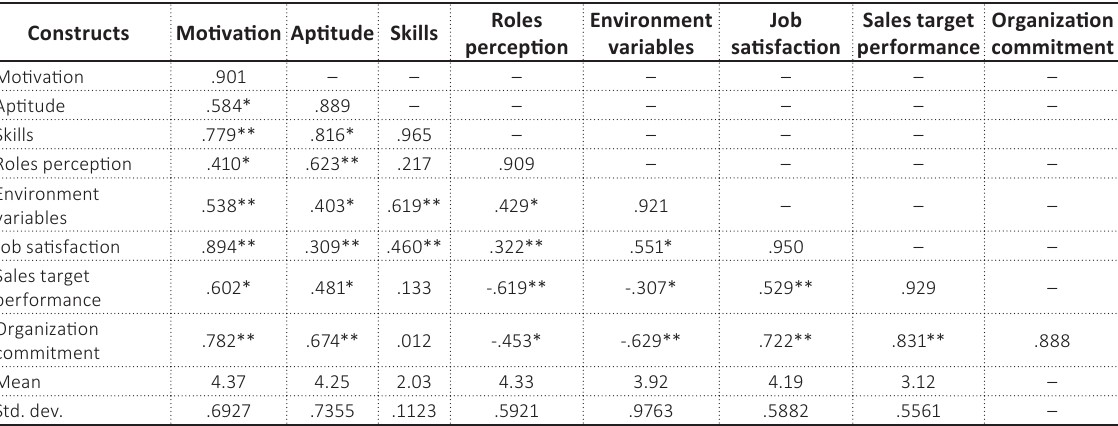
Table 2. Correlations, mean, standard deviation, and square root of AVE